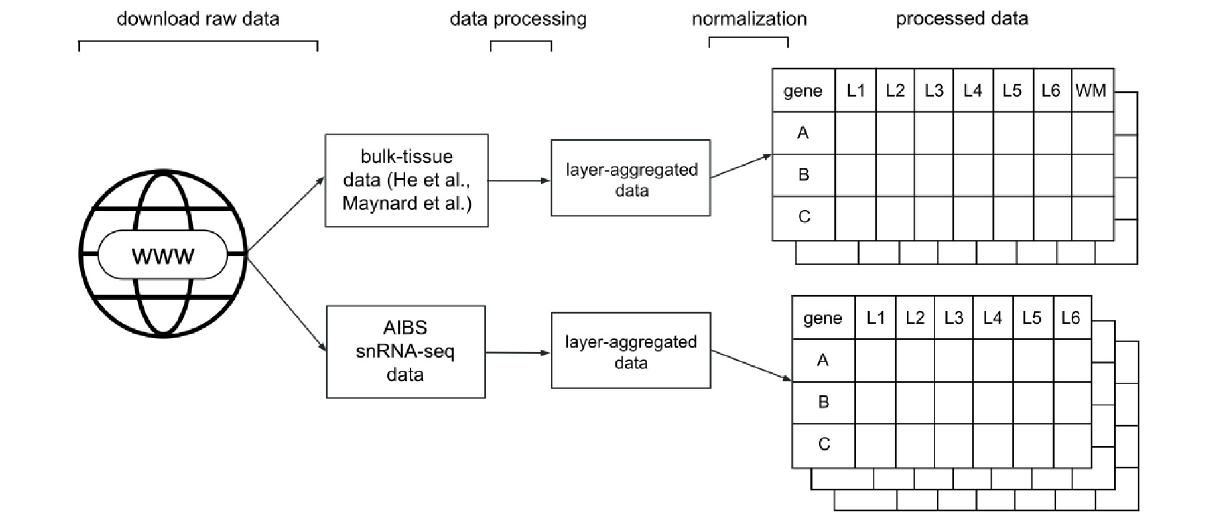
across three donors. Samples of target areas were taken from coronal sections of the brain and each layer was dissected